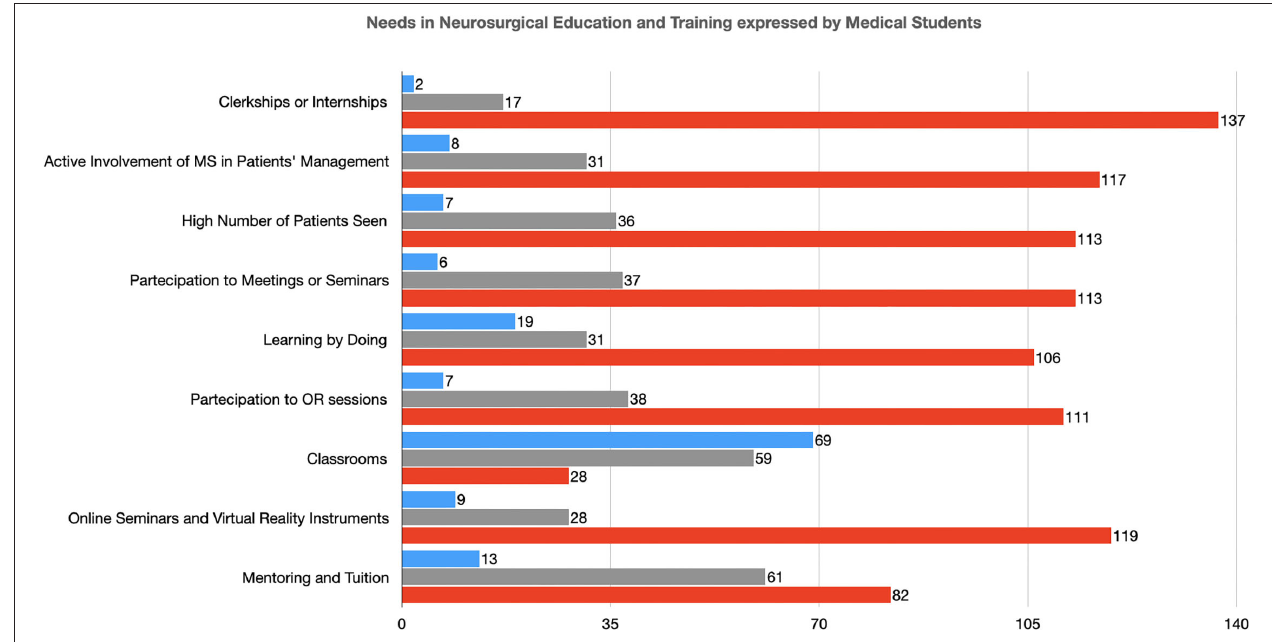
FIGURE 4 | Needs in Neurosurgical Education and Training expressed by Medical Students (MS, Medical Student; OR, Operating Room).